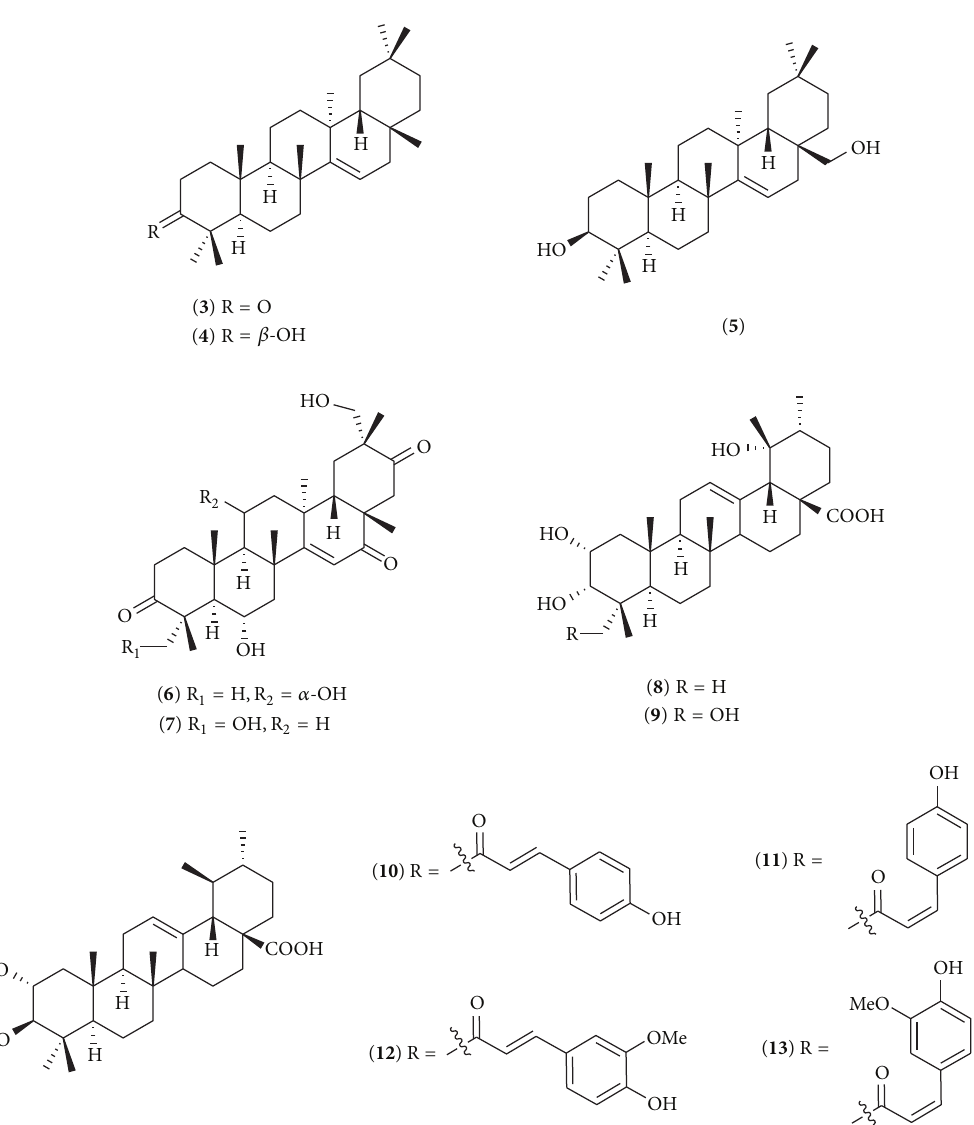
Figure 3: Taraxerane- and ursane-type